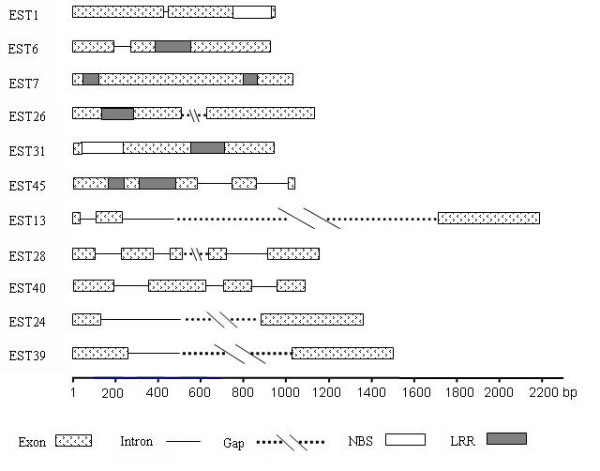
Gene structures of 11 candidate resistance genes.